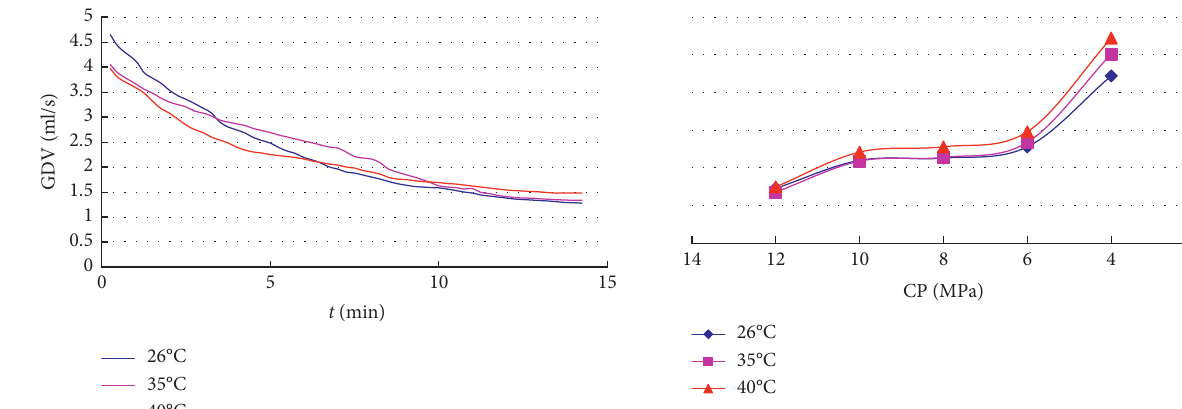
Figure 9: Variation in gas flow during confining pressure unloading at a gas pressure of 1 MPa.